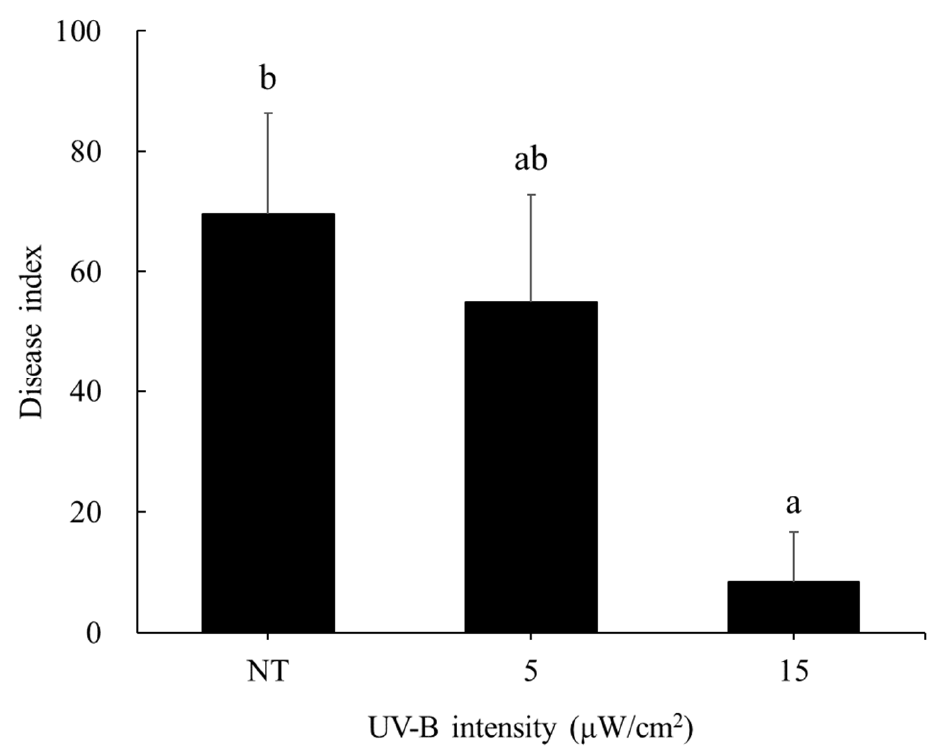
Figure 1. Preventive effect of UV ‐ B treatment against powdery mildew in cucumber. NT: non ‐ treat ‐ ment; 5:5 μ W/cm 2 for 4 h/d; 15:15 μ W/cm 2 for 4 h/d. The disease index is based on a 0–4 rating scale applied to the first leaf on each plant 7 d post ‐ inoculation. Different letters above columns indicate a significant difference between treatments. Vertical bars represent the standard error of the mean ( n = 9; Tukey’s test, p < 0.05).